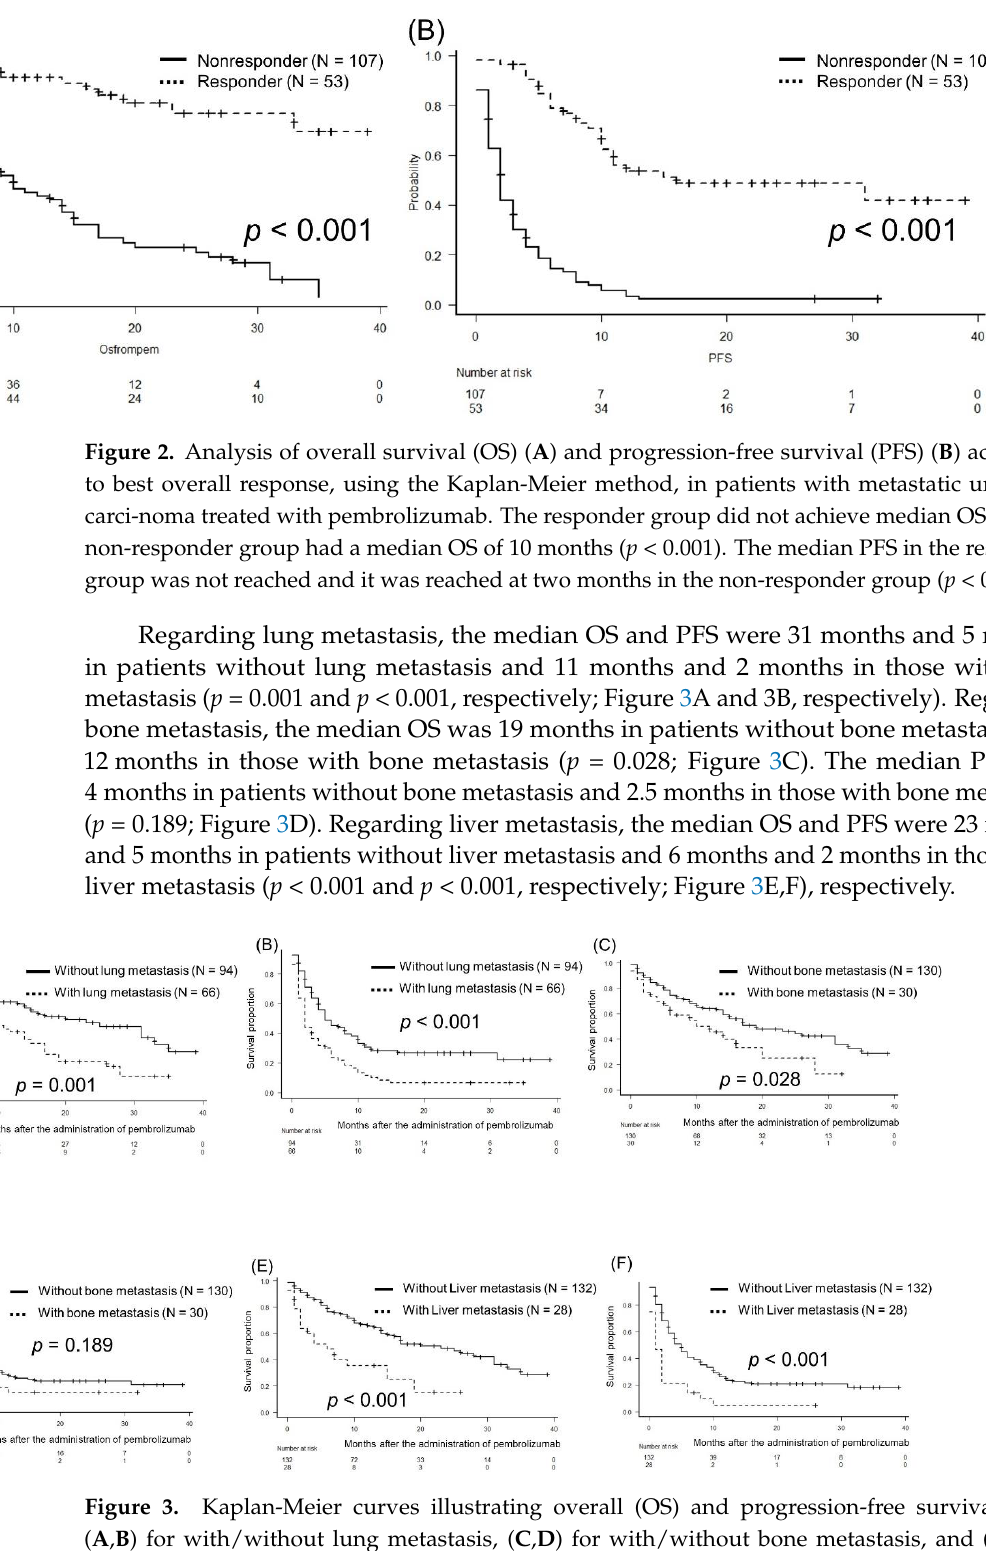
( A , B ) for with/without lung metastasis, ( C , D ) for with/without bone metastasis, and ( E , F ) for with/without liver metastasis.